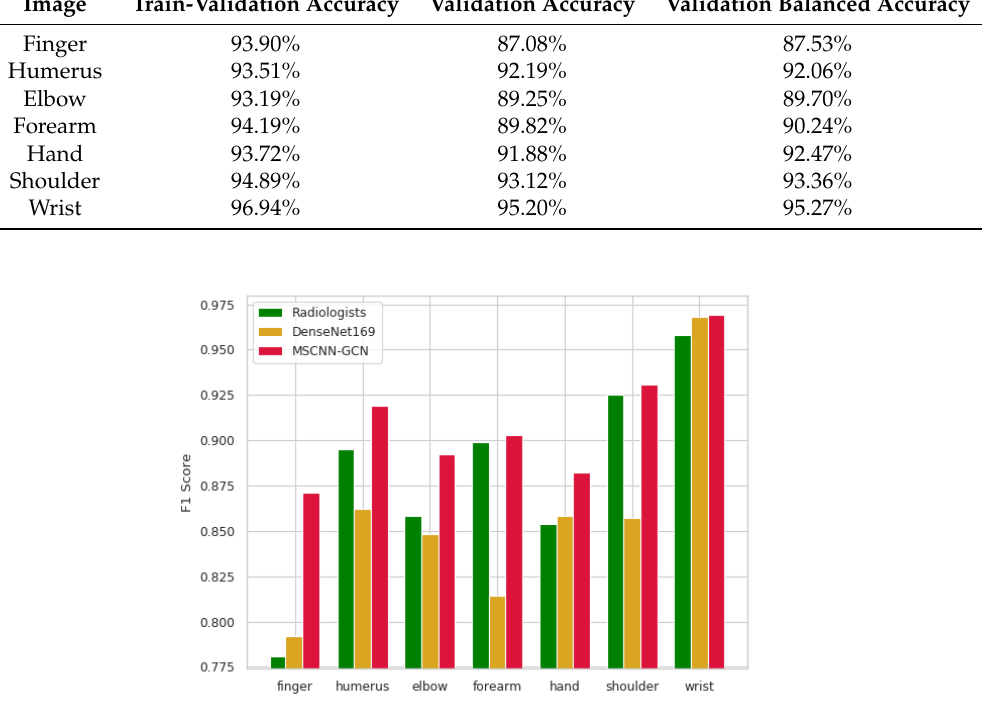
Table 2. Accuracy and balanced accuracy obtained by the proposed framework.